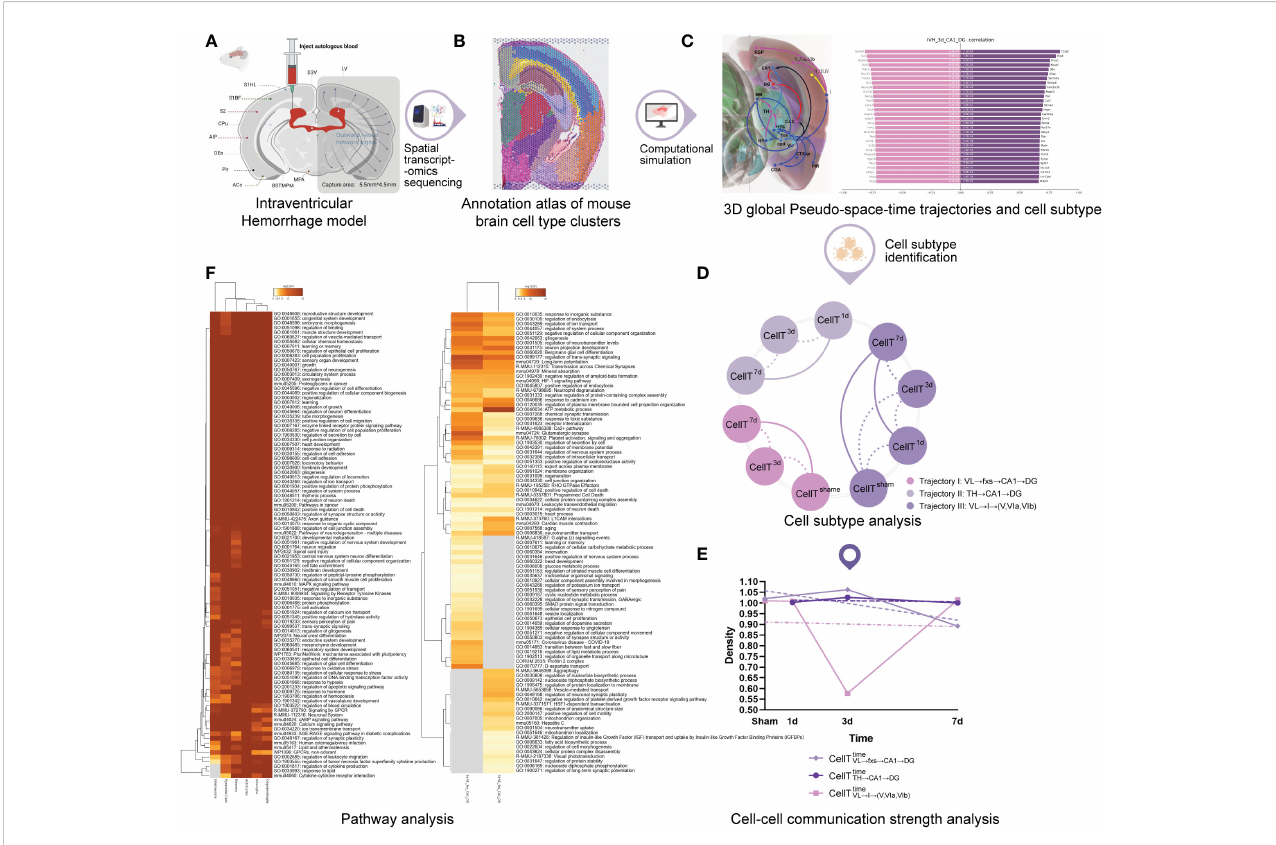
FIGURE 1 The work fl ow of the study. (A) Secondary intraventricular hemorrhage (IVH) experiment. (B) Annotation atlas of mouse brain cell-type clusters. (C) 3D global pseudospace-time trajectories and the transition gene sets. (D) Cell subtype analysis. (E) Cell − cell communication strength analysis. (F) Pathway